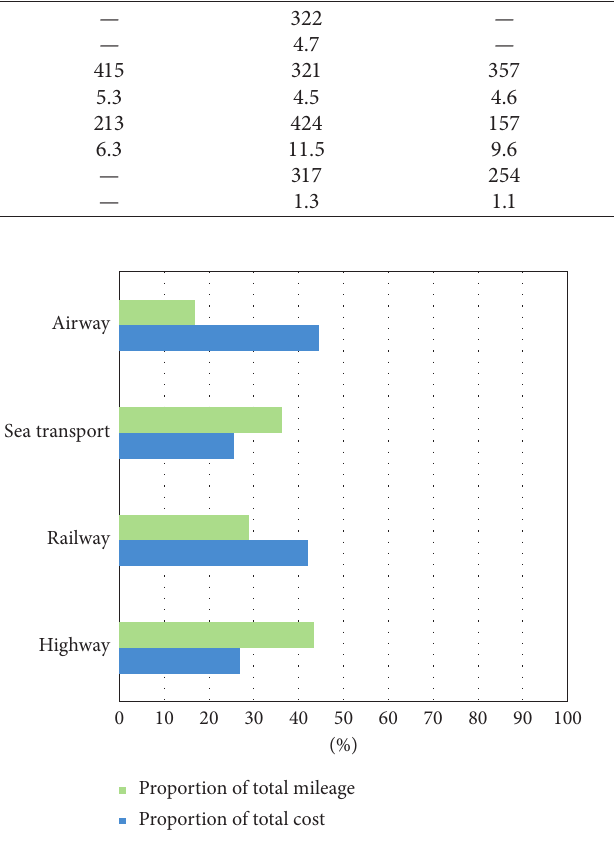
Figure 7: Proportion of different transport